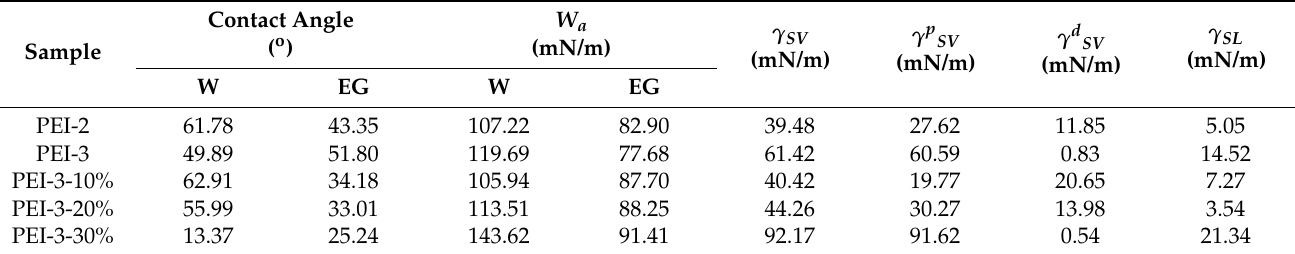
Table 2. Static contact angle values and surface parameters of prepared